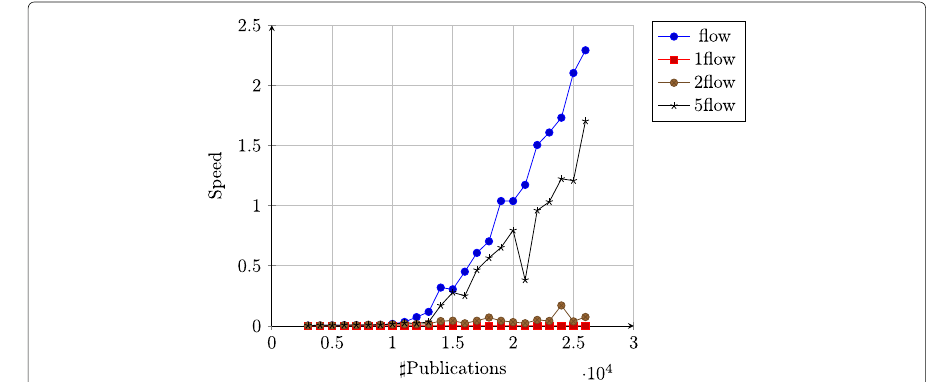
Fig. 2 Speed comparisons of our algorithm in case of k -diffuse